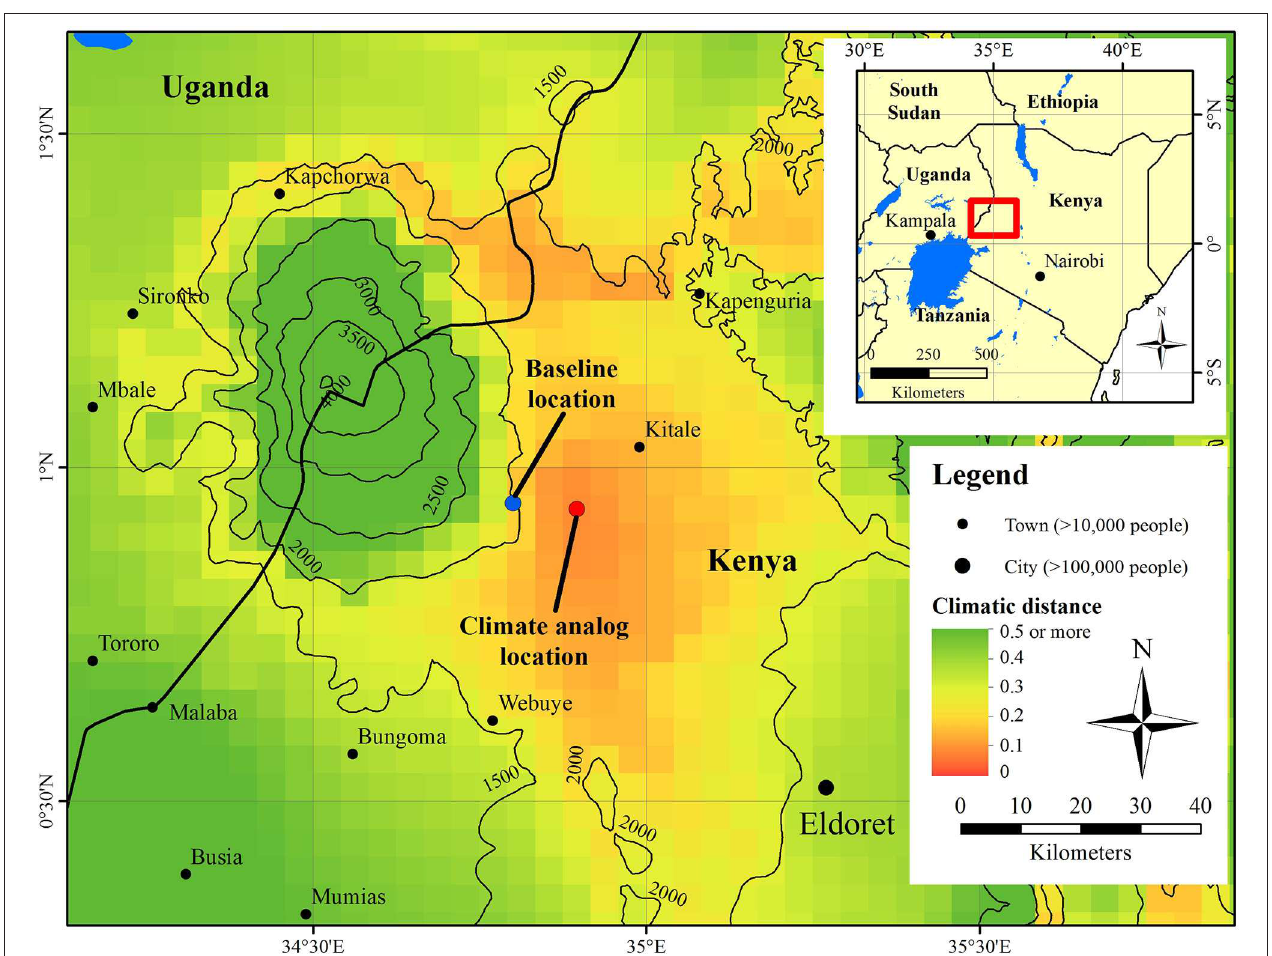
FIGURE 9 | Distribution of the climatic distance between all grid cells around Mt. Elgon, Kenya, and the projected climate at the baseline location for the 2050s, according to the CCCMA CGCM2 climate model driven by the A2a greenhouse gas emissions scenario. The climatic distance is minimized at the site designated as Climate analog location. Thin black lines are elevation contour lines based on the GTOPO30 dataset ( USGS, 1996).